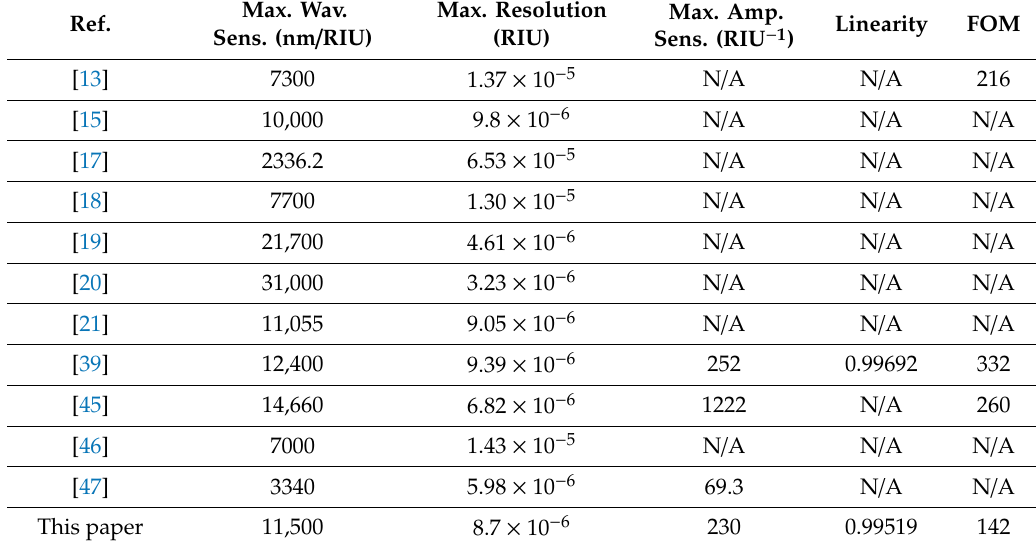
Table 1. Comparison results between our sensor and peer D-shaped sensors.